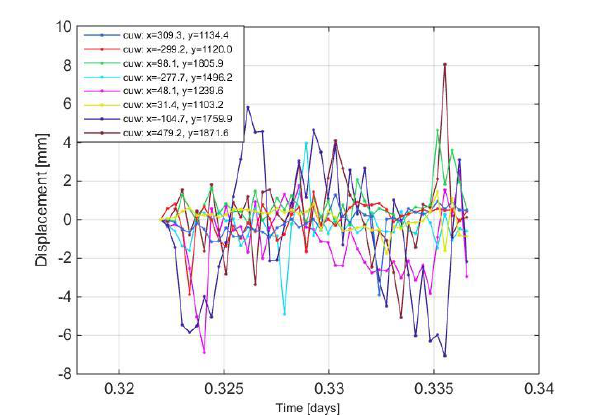
Figure 10. Deformation of PS